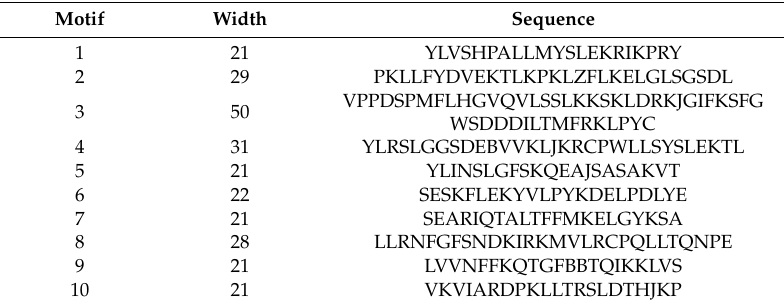
Table 3. List of putative motifs in CamTERFs .